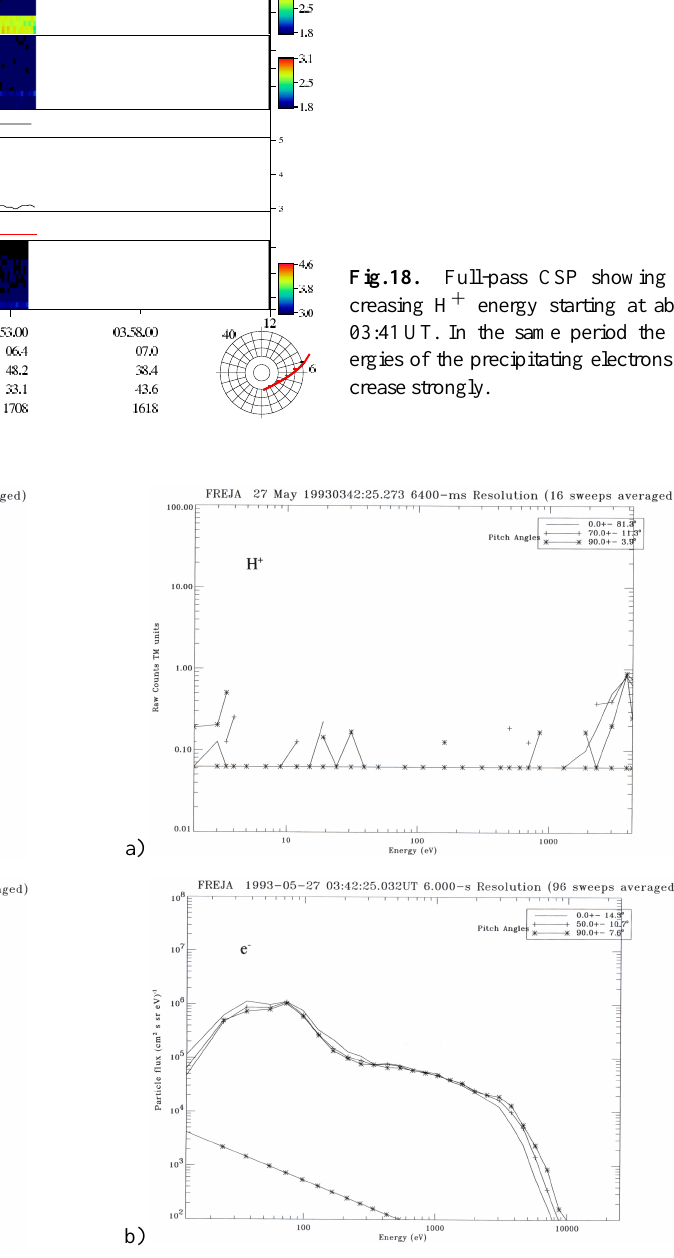
Fig.19. Measured energy spectrum of H + ions (count rate) (a) and energetic electrons (differential particle flux) (b) before the energy started to increase in Fig.18. Straight lines show 1-count levels.